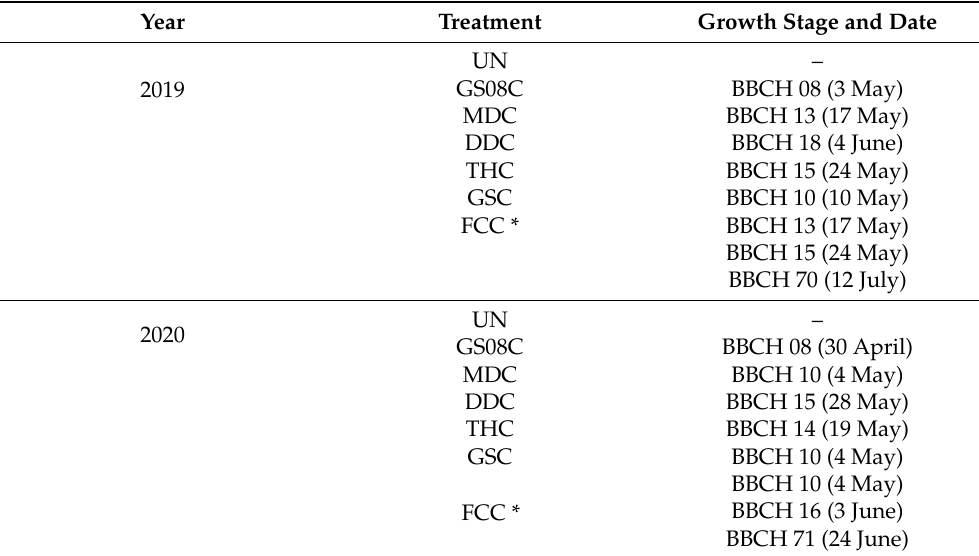
Table 2. Broad bean growth stages (BBCH) and dates of insecticide application for Sitona lineatus control in 2019–2020.